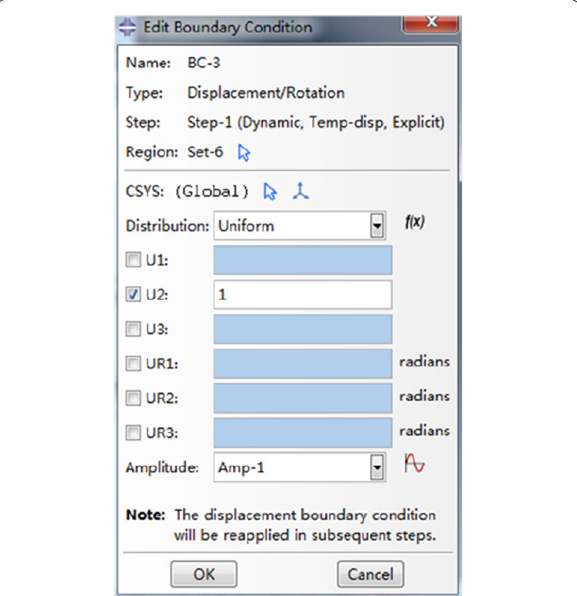
Figure 3 Load setting in ABAQUS software